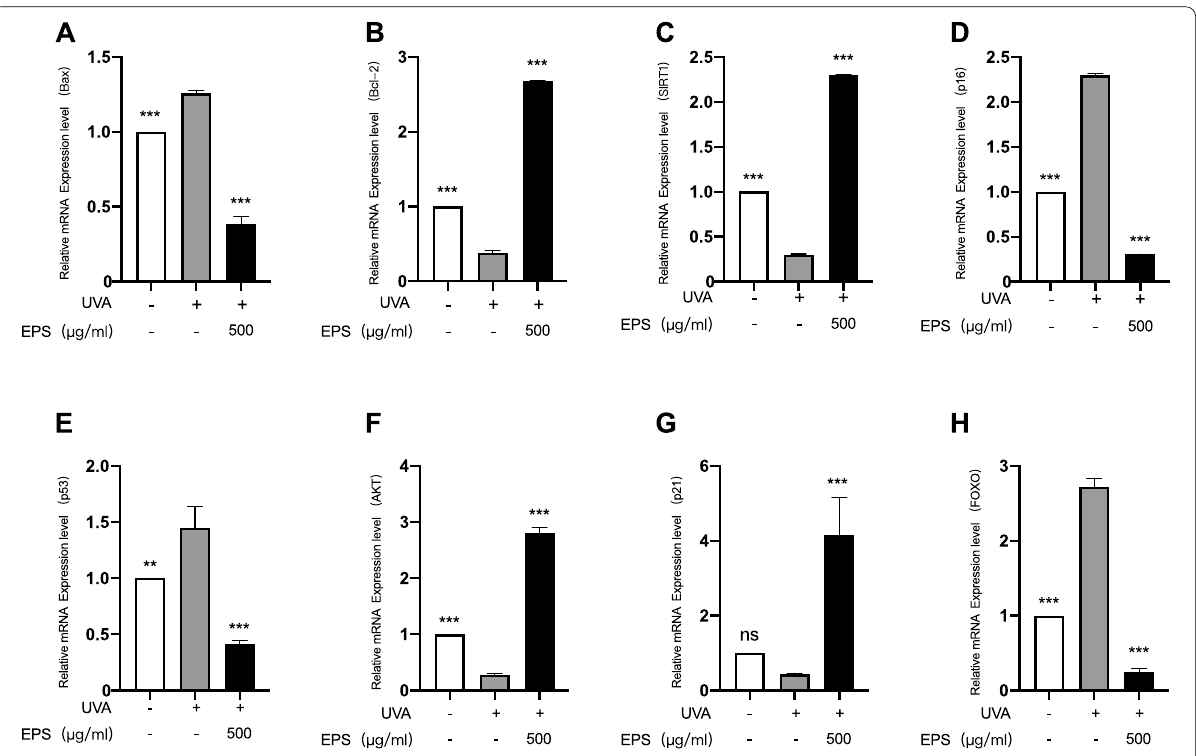
Fig. 6 Effects of different concentrations of EPS on the expression of A Bax, B Bcl-2, C SIRT1, D p16, E p53, F AKT, G p21 and H FOXO in the HSF senescence and apoptosis pathways induced by UVA. Each mRNA was referenced to the internal control gene β-actin and expressed relative to the control group. * p < 0.05, ** p < 0.01, *** p < 0.001 compared to model